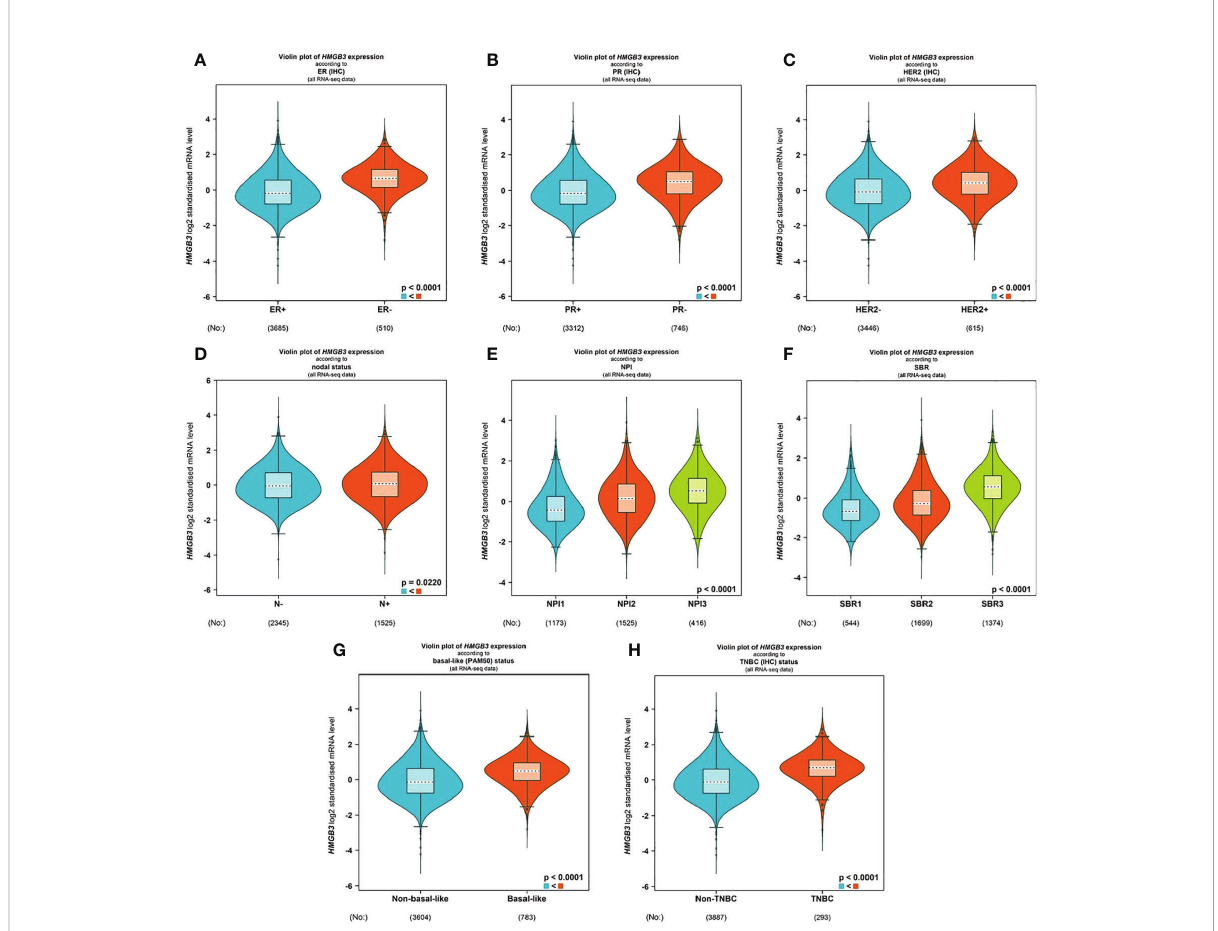
FIGURE 3 Correlation between HMGB3 expression and clinicopathological parameters. Using the software bc-GenExMiner v4.8, a violin plot was created to show the correlations between the expression of HMGB3 and several clinical and pathological markers. Information is displayed for the following variables: ER (A) , PR (B) , HER2 (C) , nodal status (D) , NPI (E) , SBR (F) , basal-like status (G) , and TNBC status (H) . ER, estrogen receptor; PR, progesterone receptor; HER2, human epidermal growth factor receptor 2; NPI, Nottingham Prognostic Index; SBR, Scarff-Bloom- Richardson; TNBC, triple-negative breast